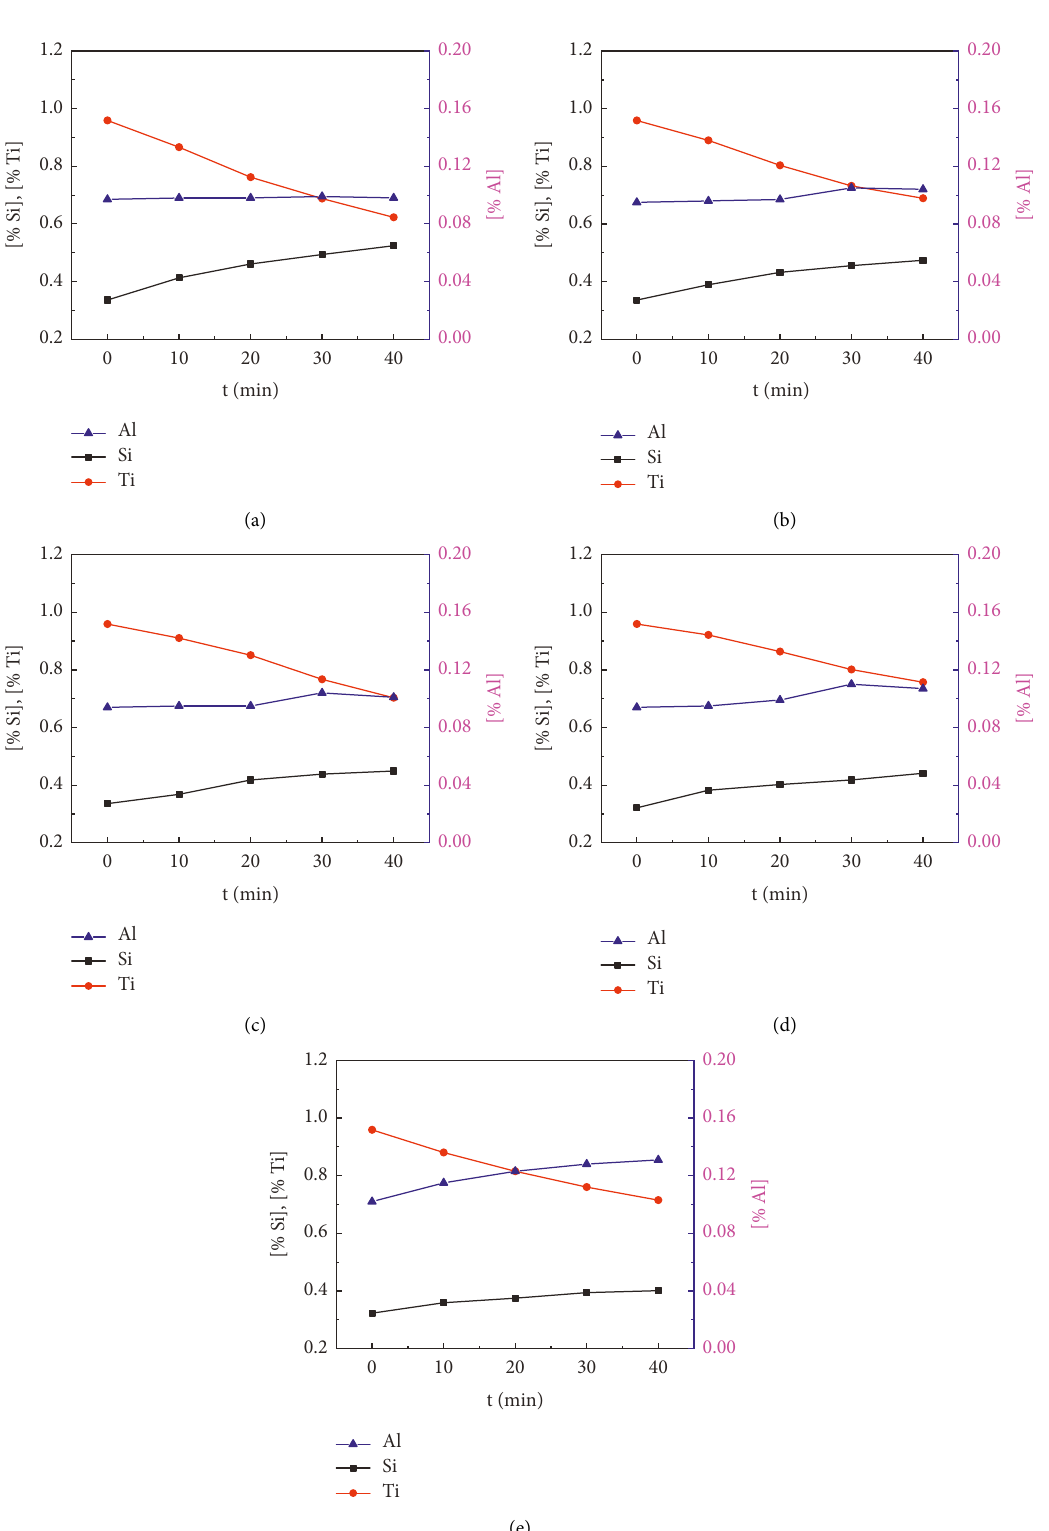
Figure 6: Changes of Al, Si, and Ti contents with time in Incoloy825: (a) S0, (b) S1, (c) S2, (d) S3, and (e)